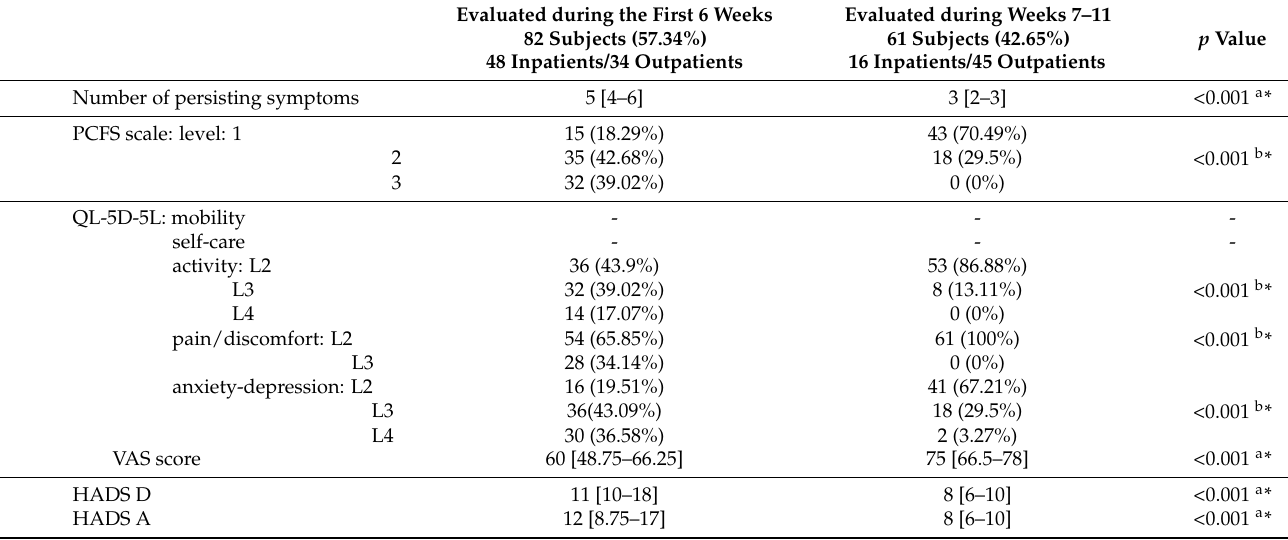
Table 3. Test results concerning the assessment